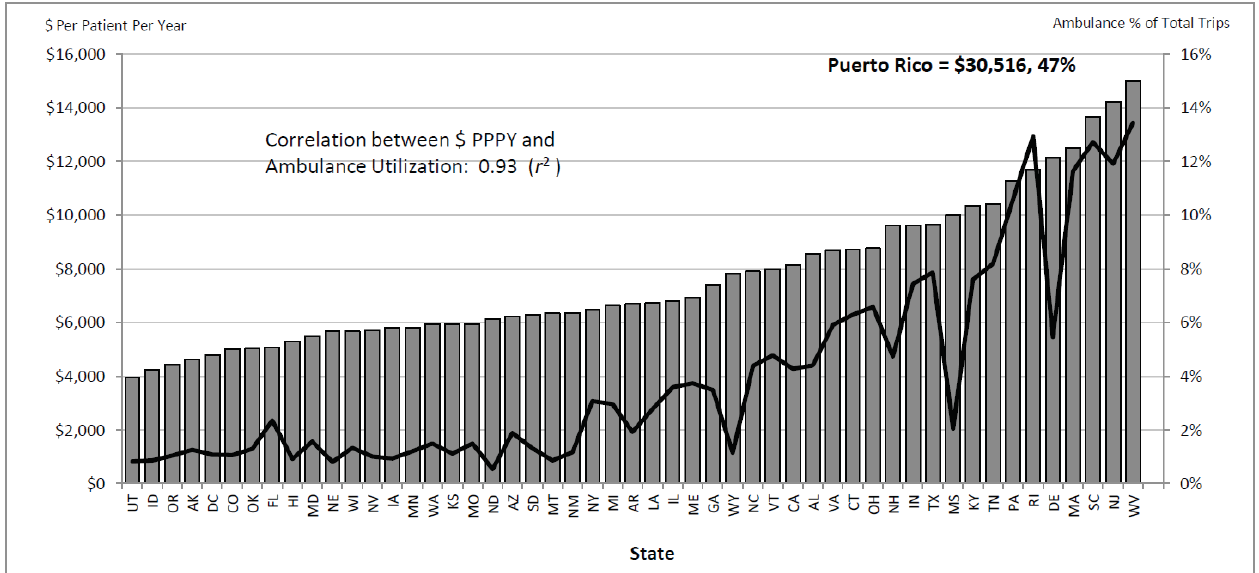
Figure 1. Dialysis Transportation Cost PPPY and Percent of Trips by Ambulance, by State